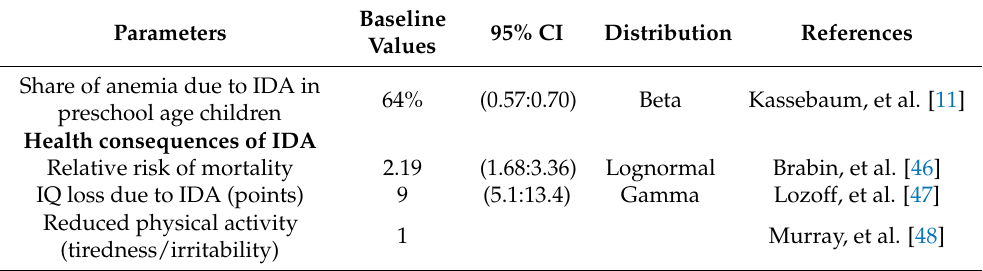
Table A1. Share of anemia due to iron deficiency and health consequences of IDA.